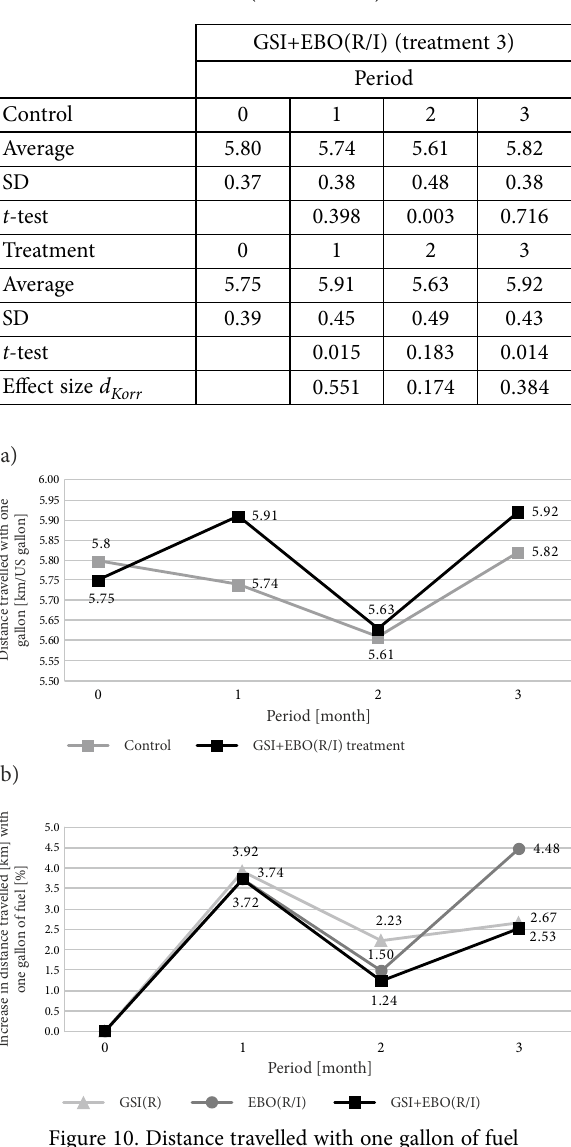
Figure 10. Distance travelled with one gallon of fuel (months 0…3): a – GSI+EBO(R/I); b – effect of the interventions in Case Studies 1